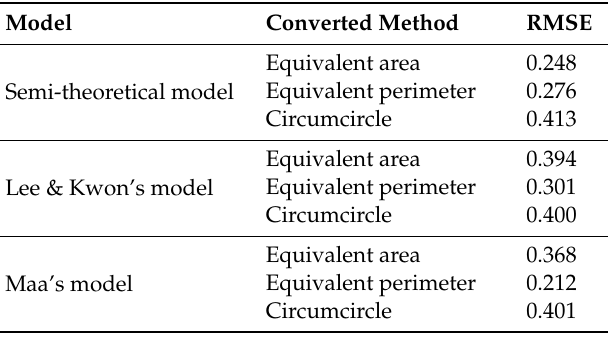
Figure 9. Scatter plot of conventional models. Table 5. RMSE of conventional models.